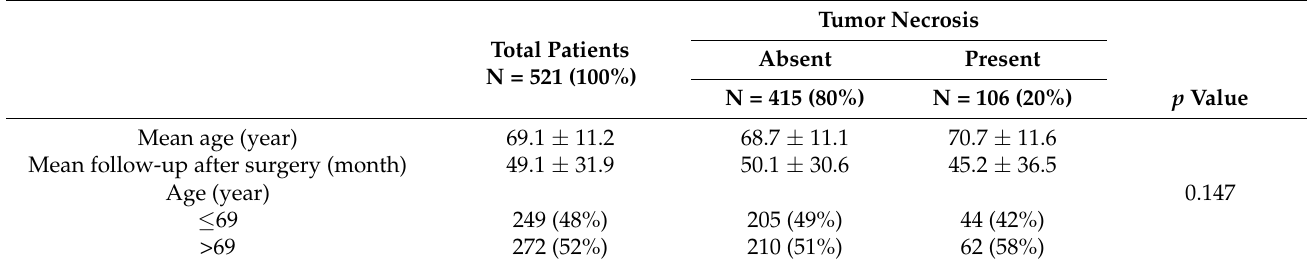
Table 1. Association of tumor necrosis with clinical and pathologic characteristics in patients treated with radical nephroureterectomy for upper tract urothelial carcinoma.